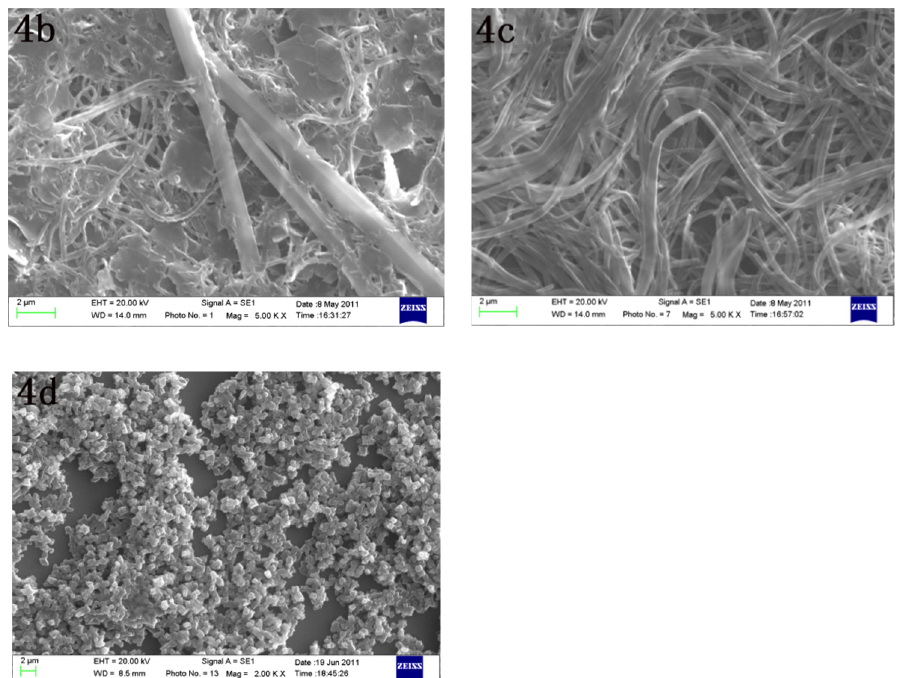
Figure 5. SEM images of micro-square tube by 4b – 4d self-assembly.